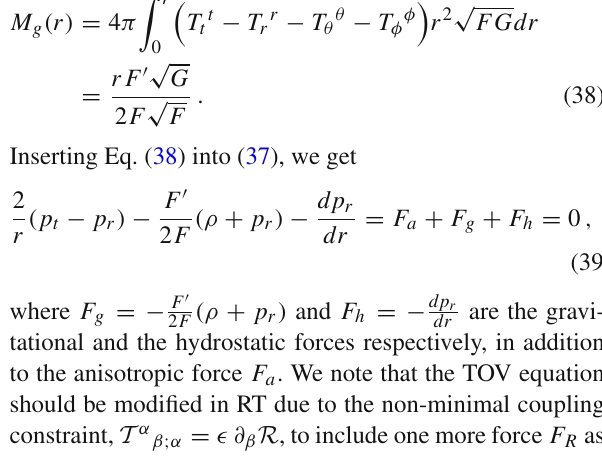
Fig. 6 The mass function plot confirm that the model can predict the a of the pulsar Her X-1 in agreement with observational data. The plot shows that RT predicts compactness values higher than GR which reflects the role of the matter-geometry coupling to allow more com-